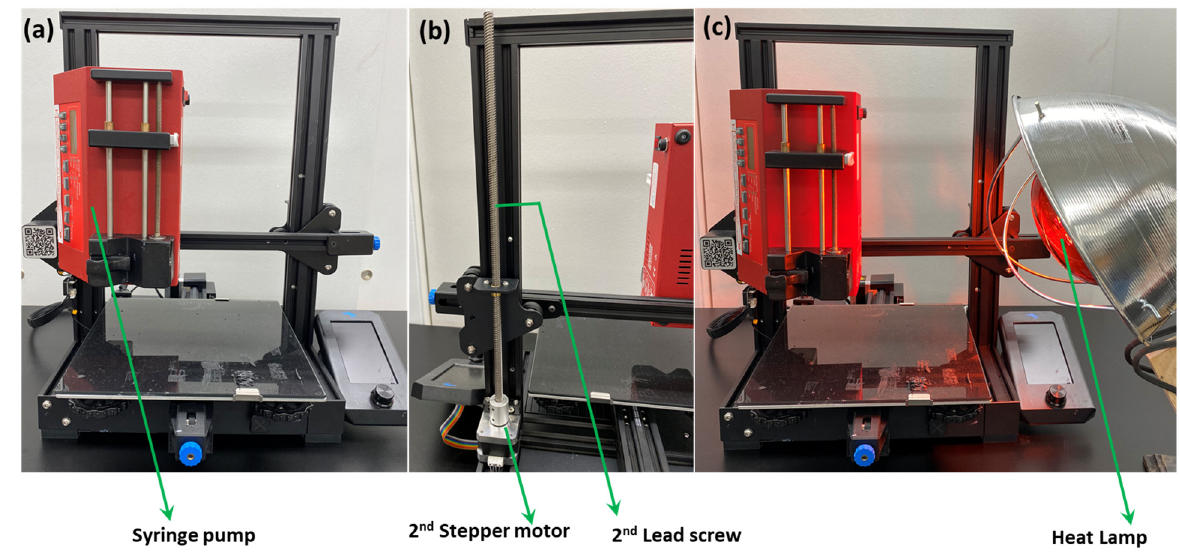
Figure 2. Different types of modifications of 3D printer.